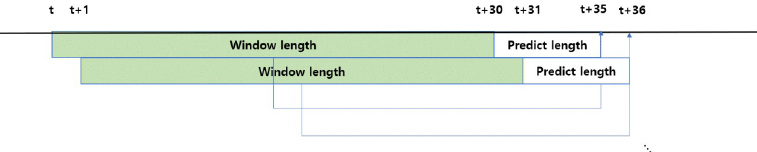
Fig 2. Setting window length, predict length and rolling window during the whole sample